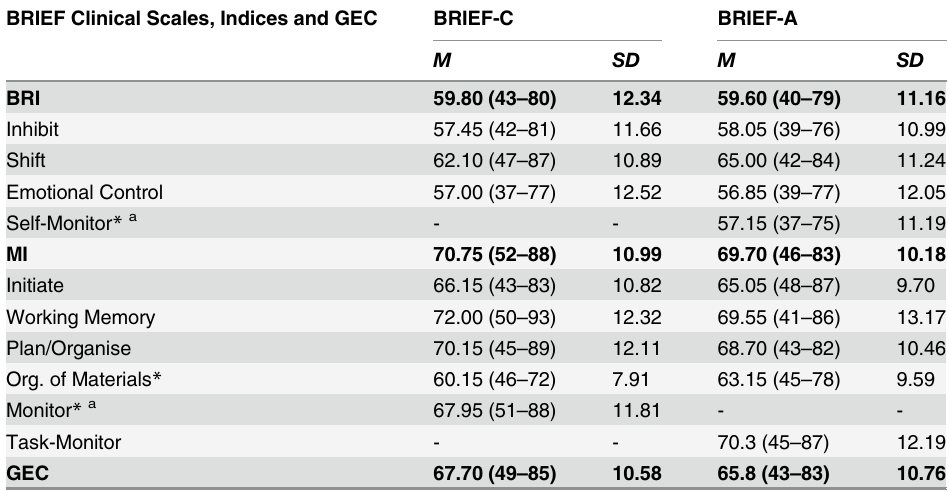
Table 1. Descriptive statistics for adult WS on the BRIEF-C and BRIEF-A T scores (N =